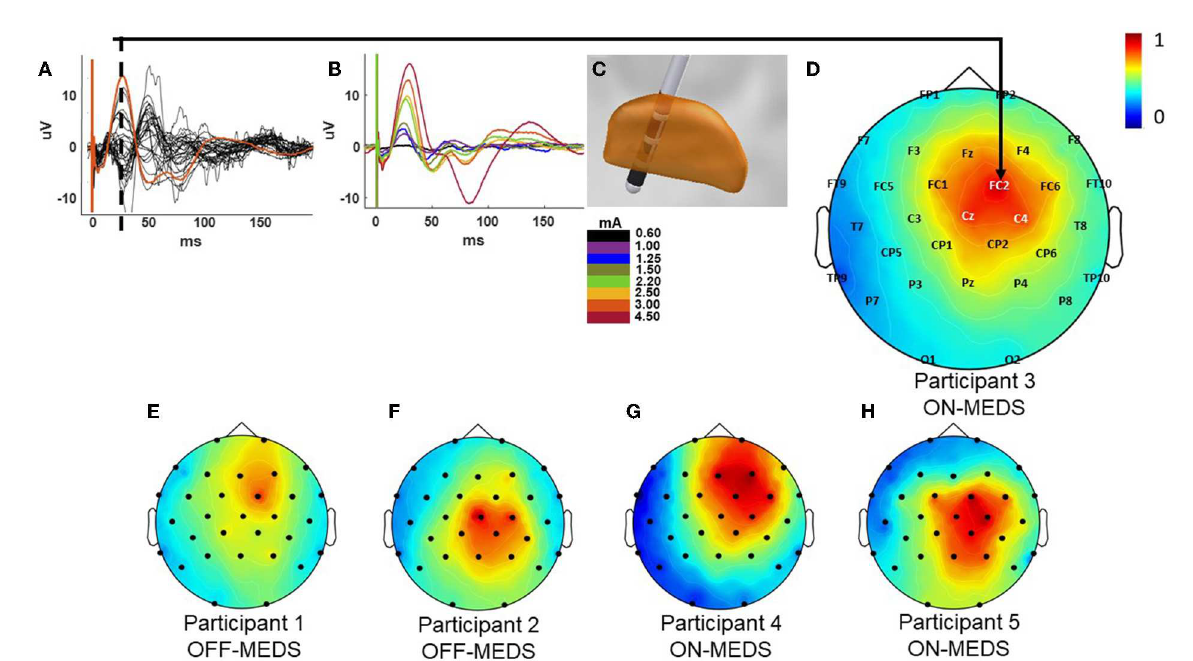
FIGURE2 Example cortical evoked potential response and the current source density (CSD) plots for all participants. Butterfly plot of the EEG recordings during stimulation at 3mA with the FC2 electrode shown in orange from participant 3 while on medication (A) . Cortical evoked response across the FC2 electrode site at increasing stimulation amplitudes from the same participant (B) . Co-registration of the DBS lead in the STN showing the stimulation contacts in red generating the responses for participant 3 shown in parts A–D (C) . CSD plot at the 25 ms time point post the onset of stimulation indicated by the dotted line in A for participant 3 (D) . The CSD plots for participants 1 & 2 [off-medication; (E,F) ] and 4 & 5 [on-medication; (G,H) ]. All CSD plots are normalized and reflect the left-right flip to align to a common (right)